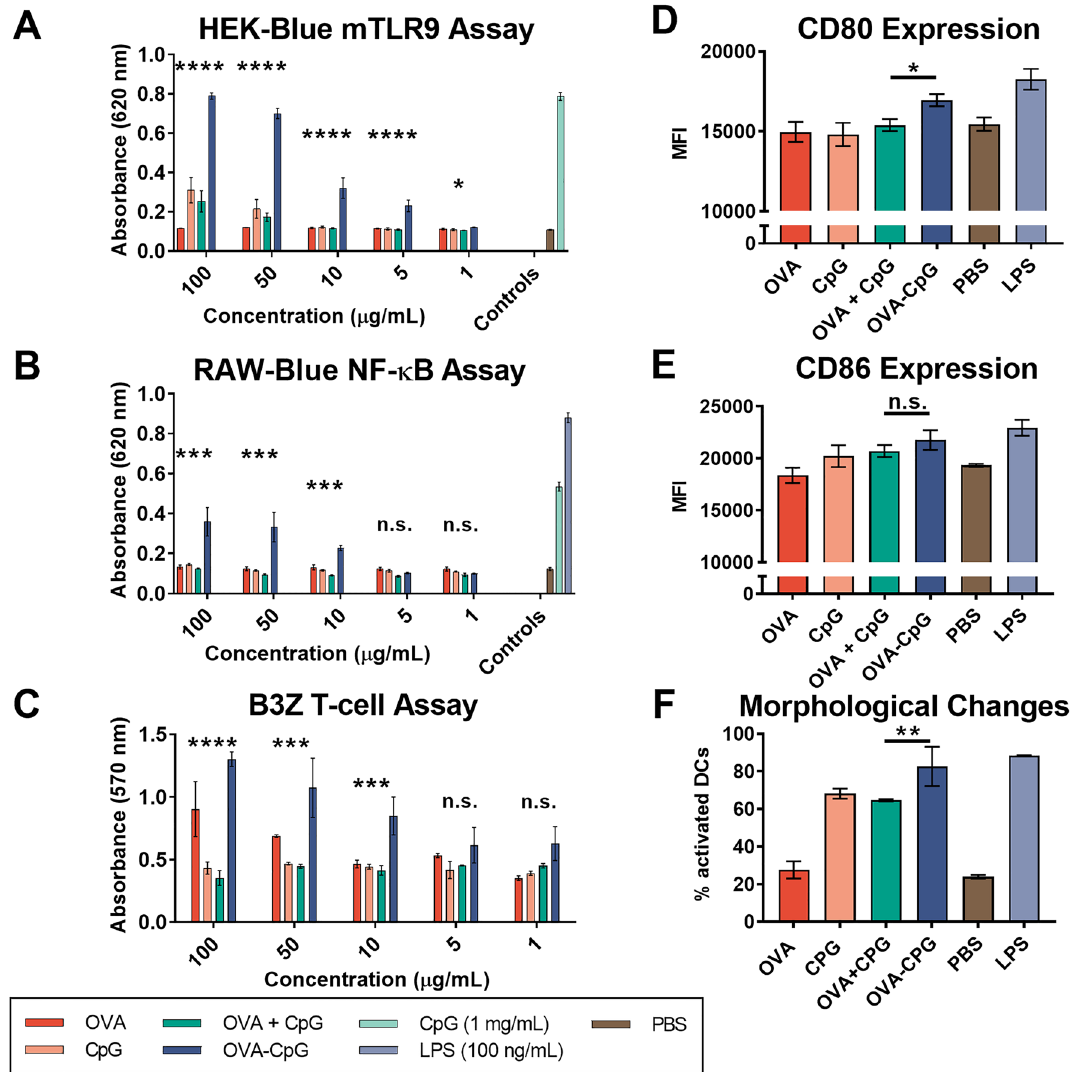
Figure 3. In vitro TLR9 activity of OVA-CpG conjugates in ( A ) HEK mTLR9 and ( B ) RAW-Blue NF-κB reporter cell activity was enhanced in OVA-CpG conjugates relative to unlinked controls. ( C ) Cross- presentation of OVA-CpG on DC2.4 cells was enhanced relative to unlinked controls as measured using the B3Z T-cell hybridoma model. Flow cytometry evaluating mean fluorescent intensity of ( D ) CD80 and ( E ) CD86 as well as ( F ) morphological changes associated with activation after stimulation with 50 μg/mL OVA-CpG or unlinked controls. Statistics were conducted using one- or two-way ANOVA with multiple comparisons testing to evaluate OVA-CpG relative to OVA +